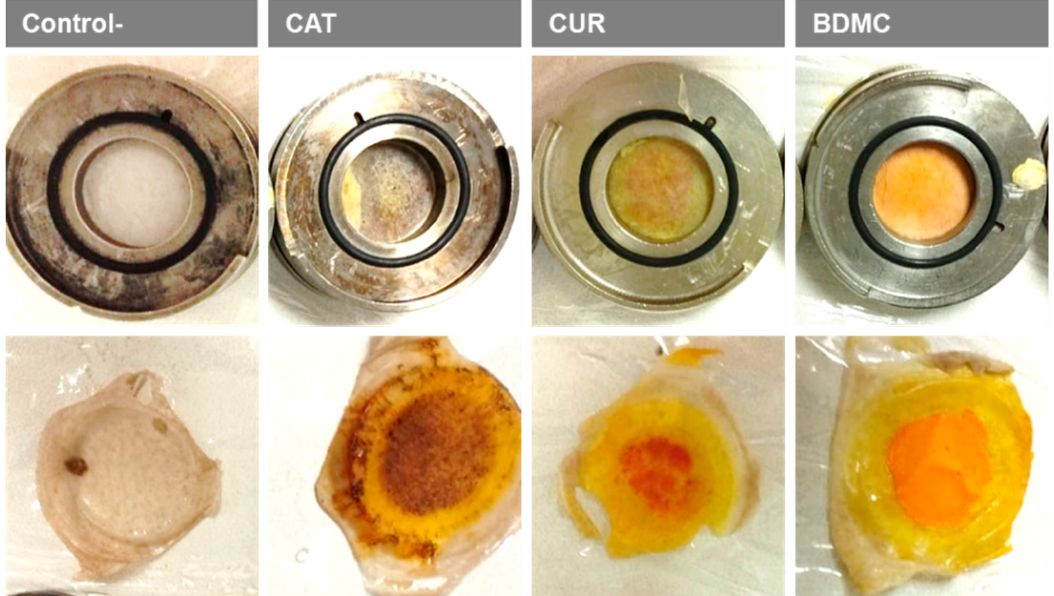
Figure 8. Ex vivo human skin pieces after permeation experiments with curcuminoids applied for 24 h on the skin; upper panels: mounted in the joint. The effective diffusional area was 2.54 cm 2 , lower panels: taken out of the joint. Ethanol without curcuminoid was applied as the negative control (Control − ).